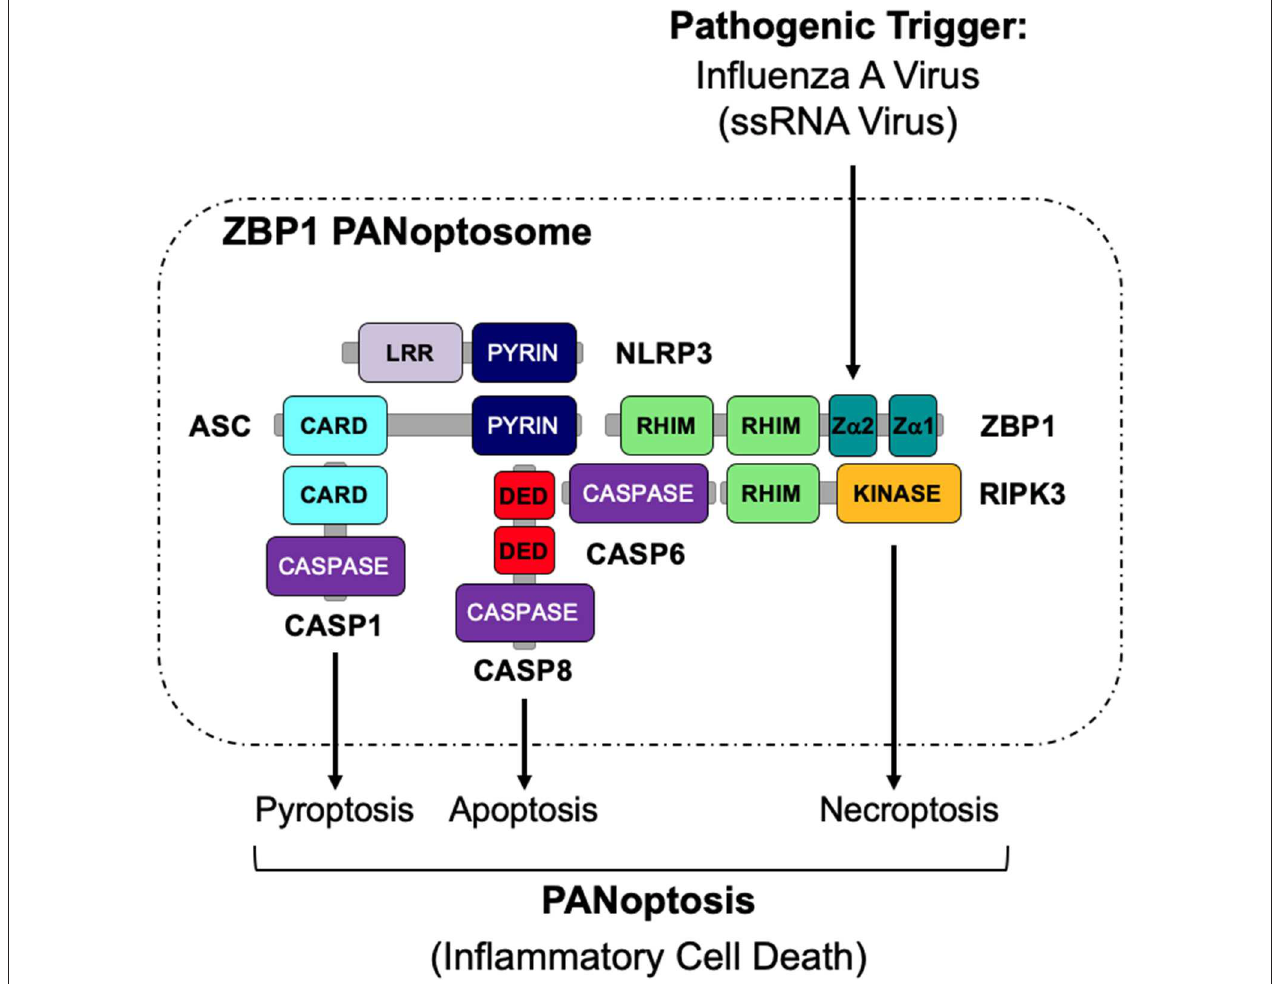
FIGURE 5 | Graphical representation of a PANoptosome. Schematic summary of a representative PANoptosome formed after IAV infection. Domains hypothesized to be crucial for mediating PANoptosome formation are